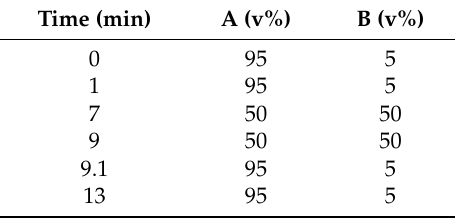
Table 3. The gradient conditions for hydrophilic separation of polar